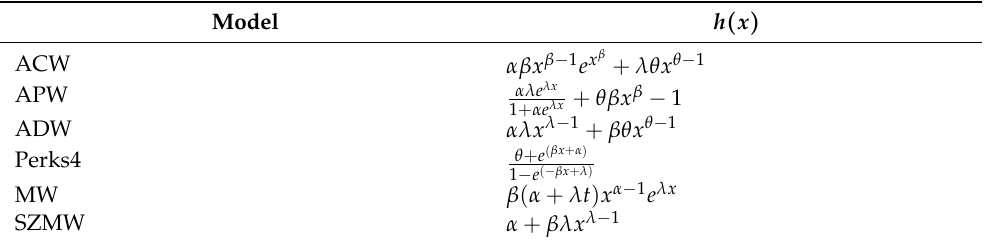
Table 1. Bathtub Shape